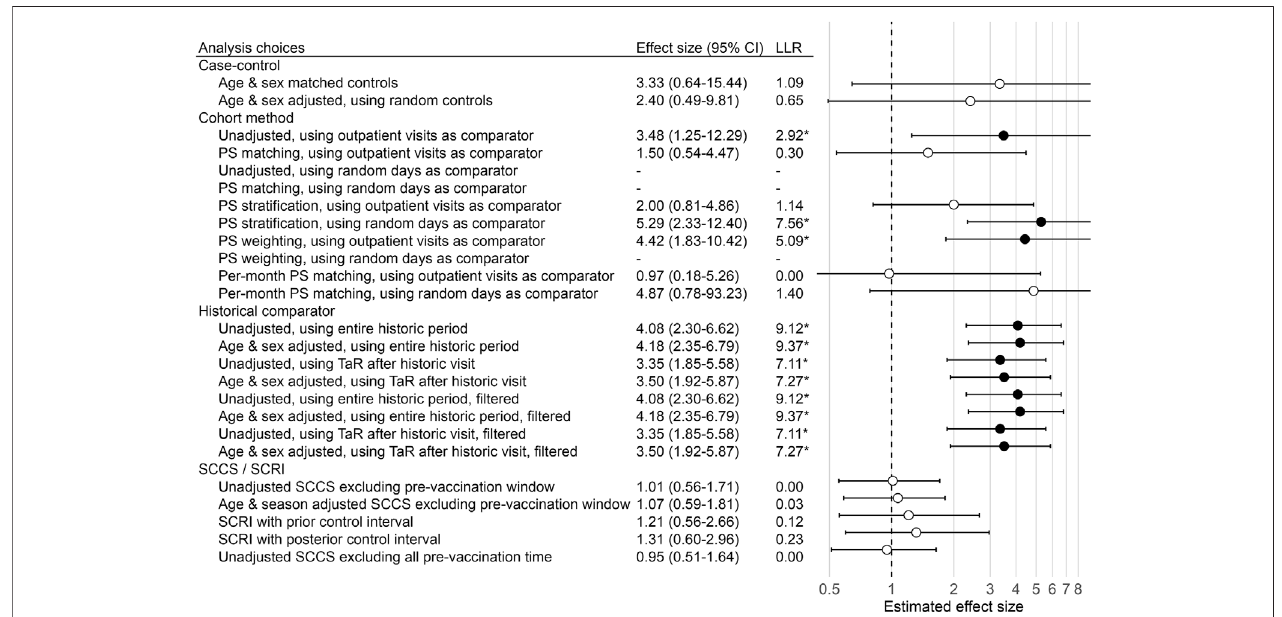
FIGURE 1 | Effect size estimates, 95% CI, and LLRs for one example control. We use each analysis variation to estimate the causal effect size of H1N1pdm vaccination on the risk of “ contusion of toe ” in the Optum EHR database, using the data across all 9 months. The true effect size is 1, as indicated by the dashed line. ‘ * ’ and fi lled dots indicates the LLR exceeds the critical value. CI = Con fi dence Interval, LLR = Log Likelihood Ratio, TaR = Time-at-Risk.